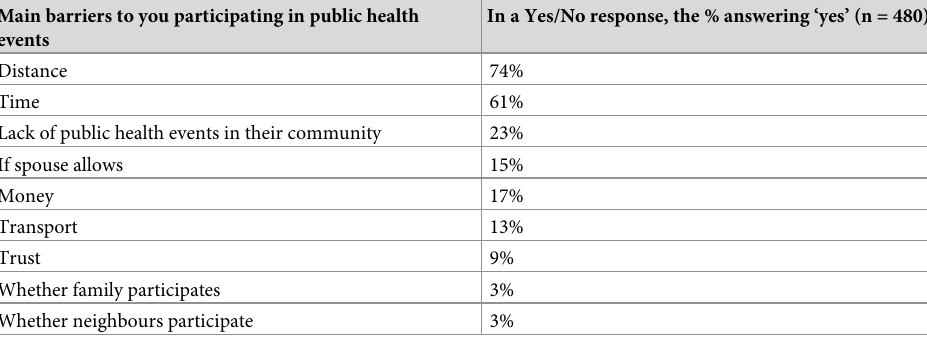
Table 7. Survey responses to barriers to participating in public health events. S1